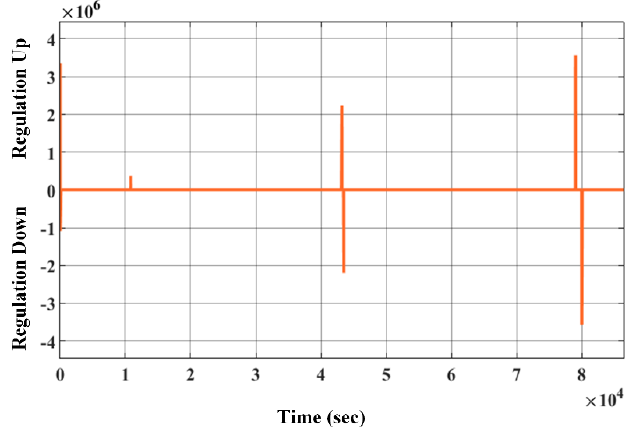
Figure 13. Real-time battery state of charge for the four EVs under consideration for ( a ) TYPE 1, Charging Station 2 and ( b ) TYPE 2, Charging Station 2.